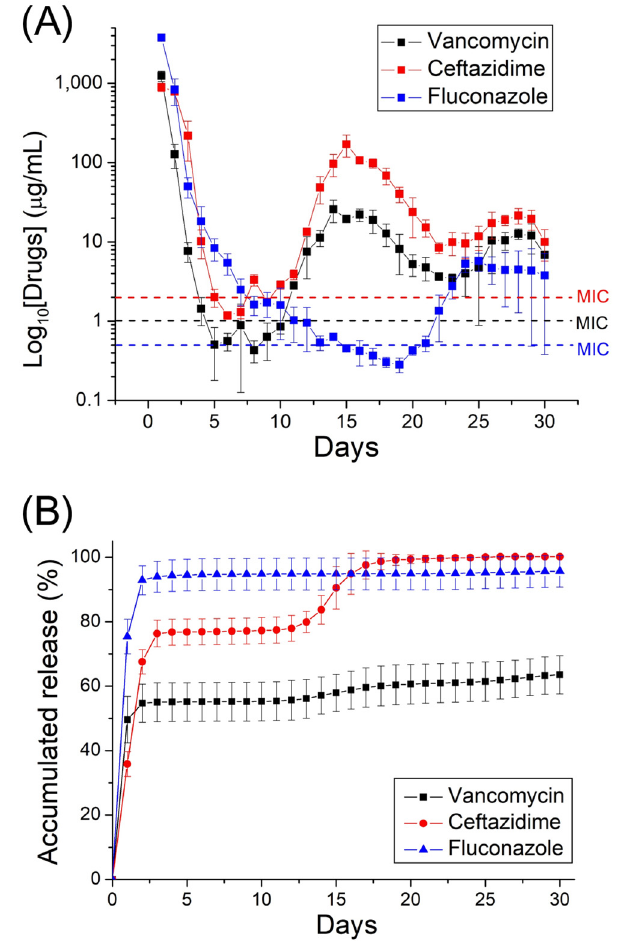
Figure 6. In vitro ( A ) daily, and ( B ) accumulated, release of pharmaceuticals from electrospun nanofibers (the minimum inhibitory concentrations of vancomycin, ceftazidime, and fluconazole are 1.0, 2.0, and 0.5 µ g/mL, respectively).